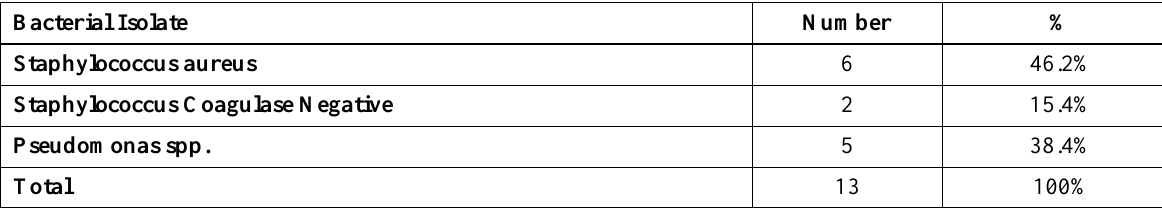
Table 7. Diagnostic performance of 10% KOH and CFW compared to culture on SDA. Culture on